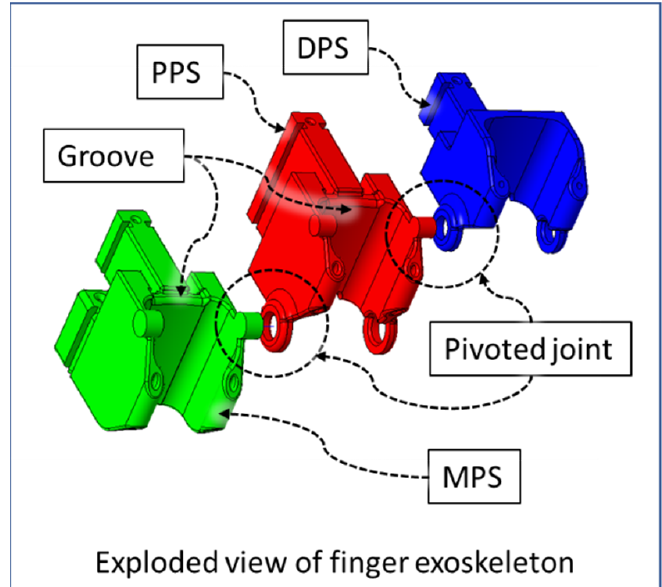
Figure 5. Exploded view of finger exoskeleton.